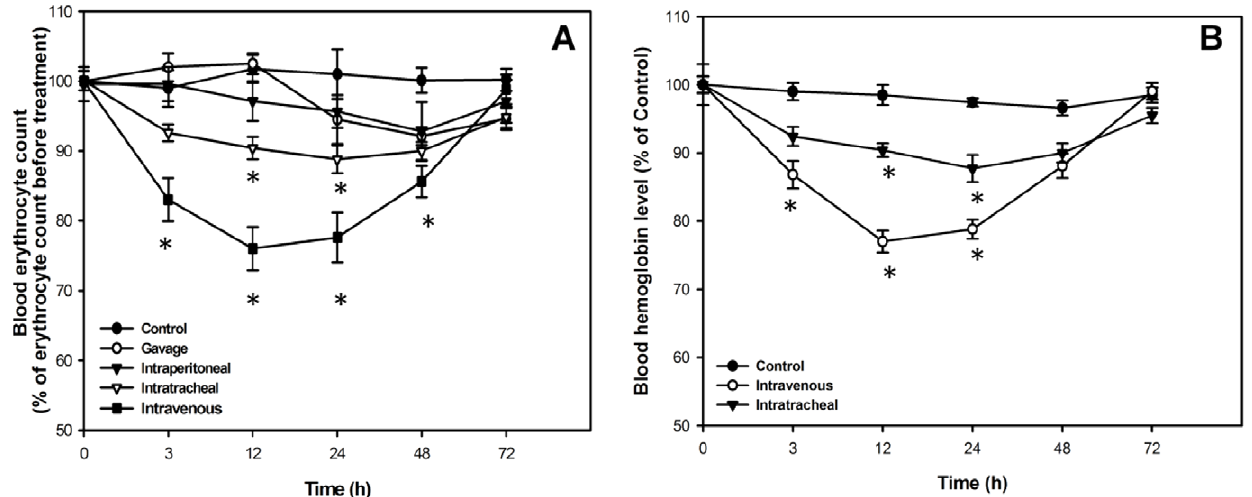
Figure 6. Effect of AF-SWCNT’s on blood count of erythrocytes in mice. AF-SWCNT’s were administered to 6–8 weeks old Swiss mice by the indicated routes (panel A). Mice were administered vehicle (PBS alone) or AF-SWCNT’s (100 m g) intravenously, intratracheally, intraperitoneally, or the gavage route, and erythrocyte count was determined at different time intervals. Panel B shows effect of intravenously administered control and acid functionalised SWCNTs on hemoglobin content in blood. Results of a representative experiment have been shown. All data points represent mean 6 SEM of three observations. *p , 0.01 as compared to PBS administered control groups.